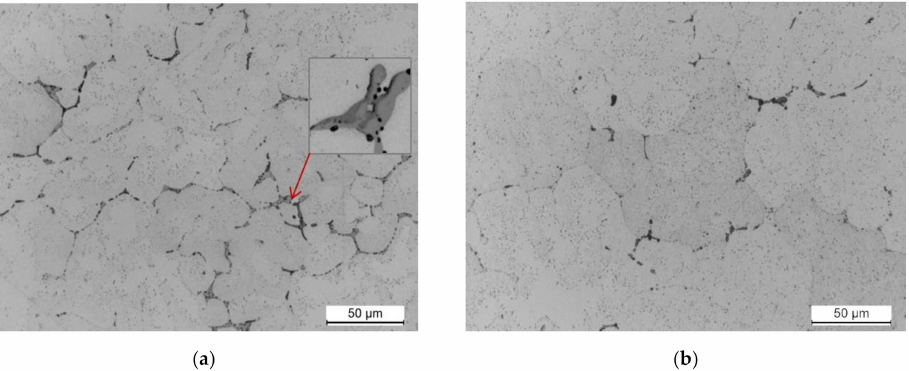
Figure 9. Microstructure of the 2017A alloy after solution heat treatment from ( a ) 490 ◦ C and ( b ) 510 ◦ C and natural